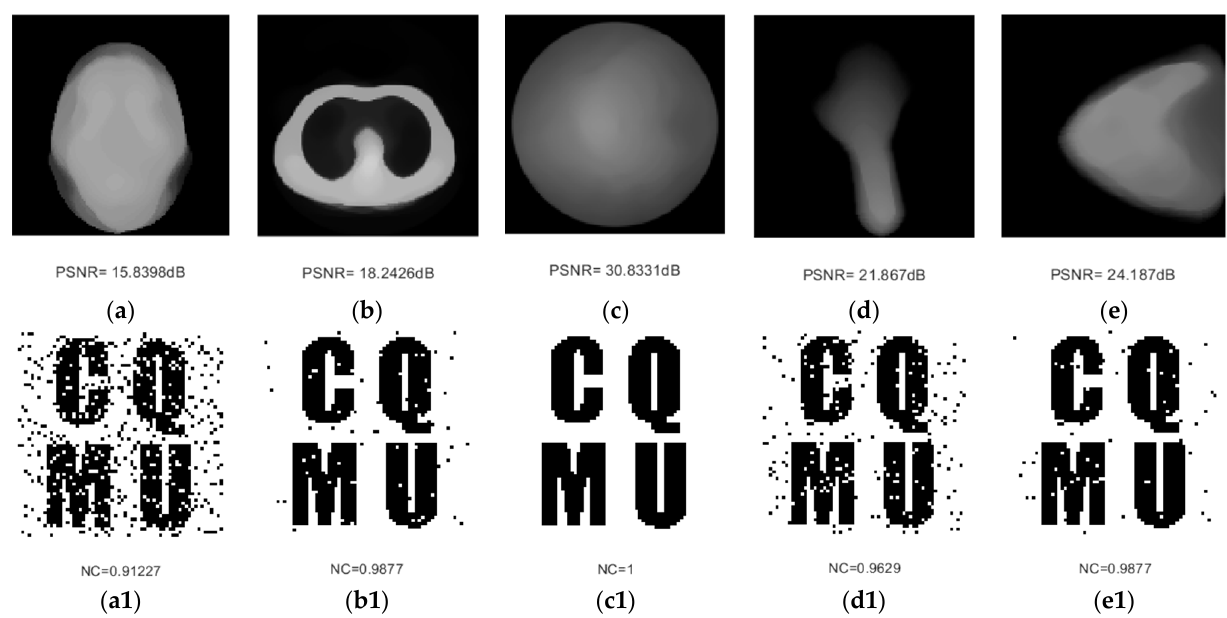
Figure 11. Attacked medical images and restored watermarking images under (7 × 7), 20 times median filter attacks: ( a , a1 ) brain and extracted watermarking image; ( b , b1 ) chest and extracted watermarking image; ( c , c1 ) fundus blood vessels and extracted watermarking image; ( d , d1 ) hand and extracted watermarking image; and ( e , e1 ) breast and extracted watermarking image. Table 3. The result under median filter attacks.